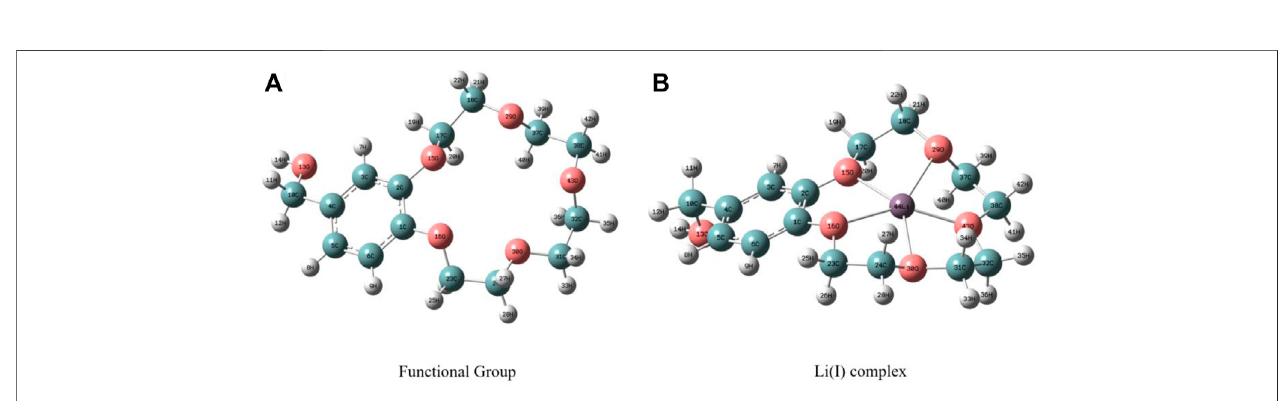
Frontiers in Energy Research |